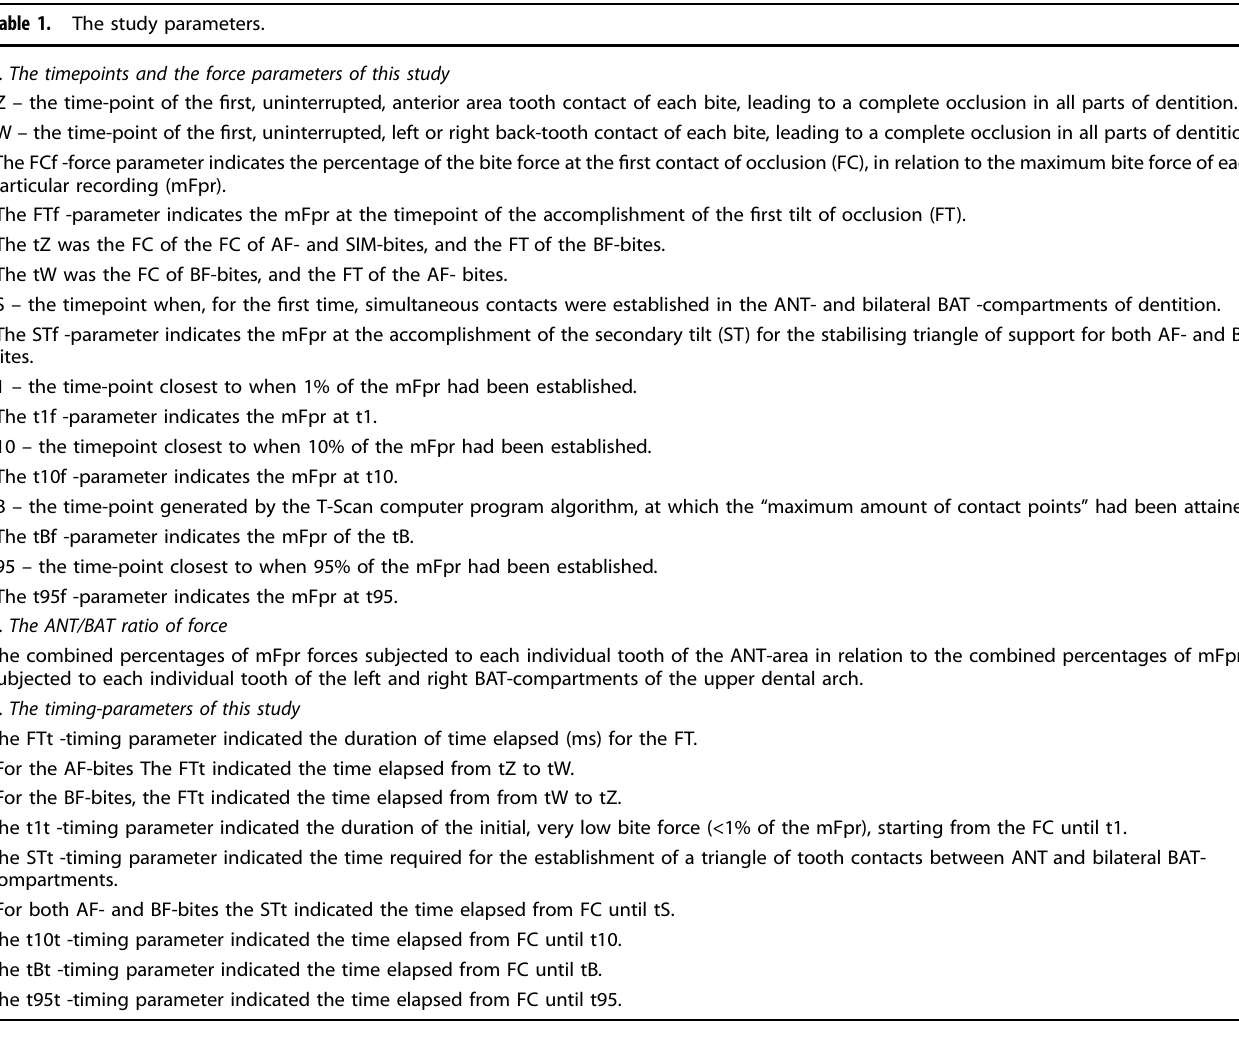
Table 1. The study